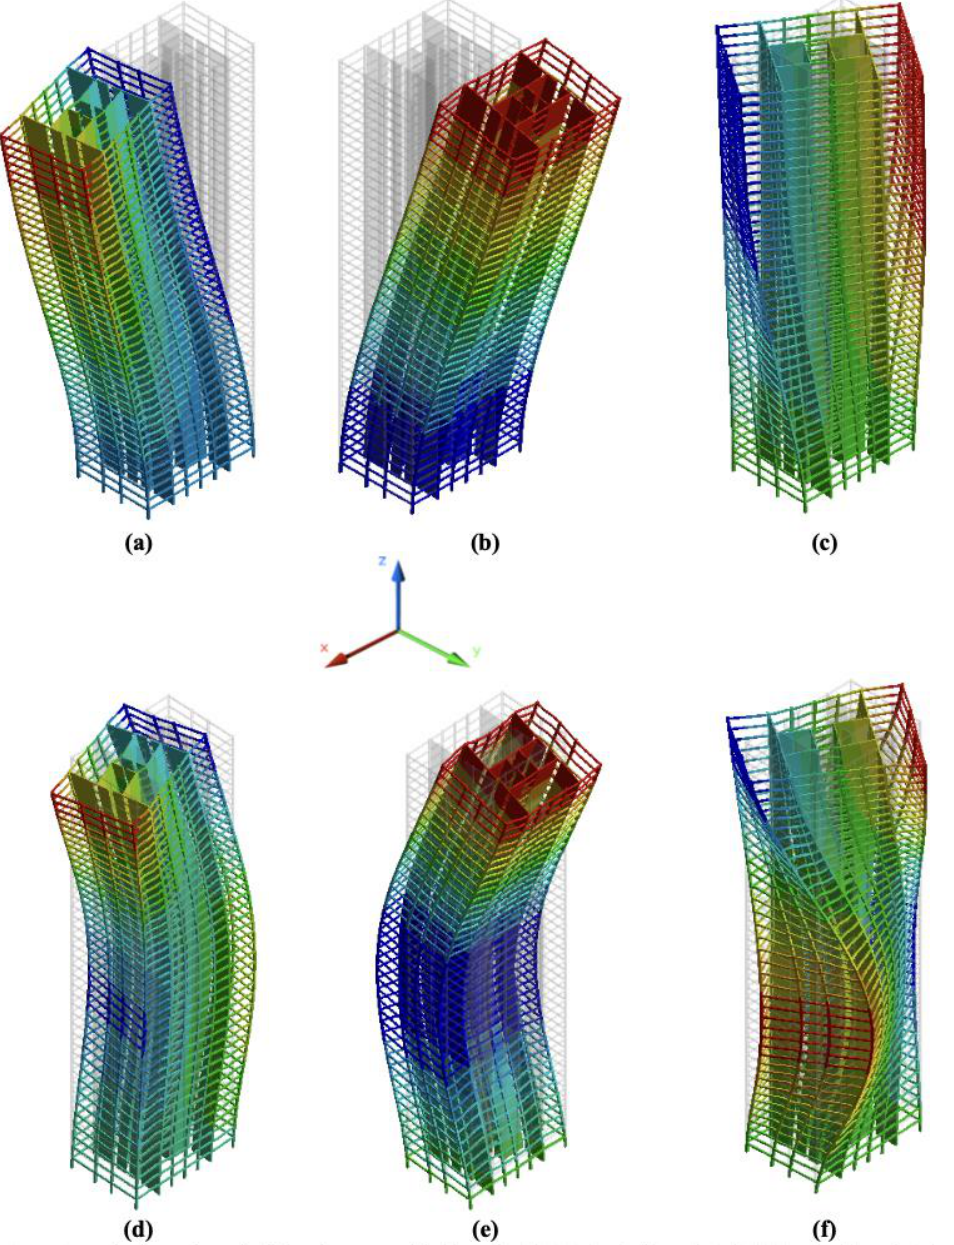
Figure 3. Mode shapes from the finite element model: ( a ) mode 1 (0.3896 Hz), ( b ) mode 2 (0.4229 Hz), ( c ) mode 3 (0.7948 Hz), ( d ) mode 4 (1.466 Hz), ( e ) mode 5 (1.699 Hz), and ( f ) mode 6 (1.963 Hz).